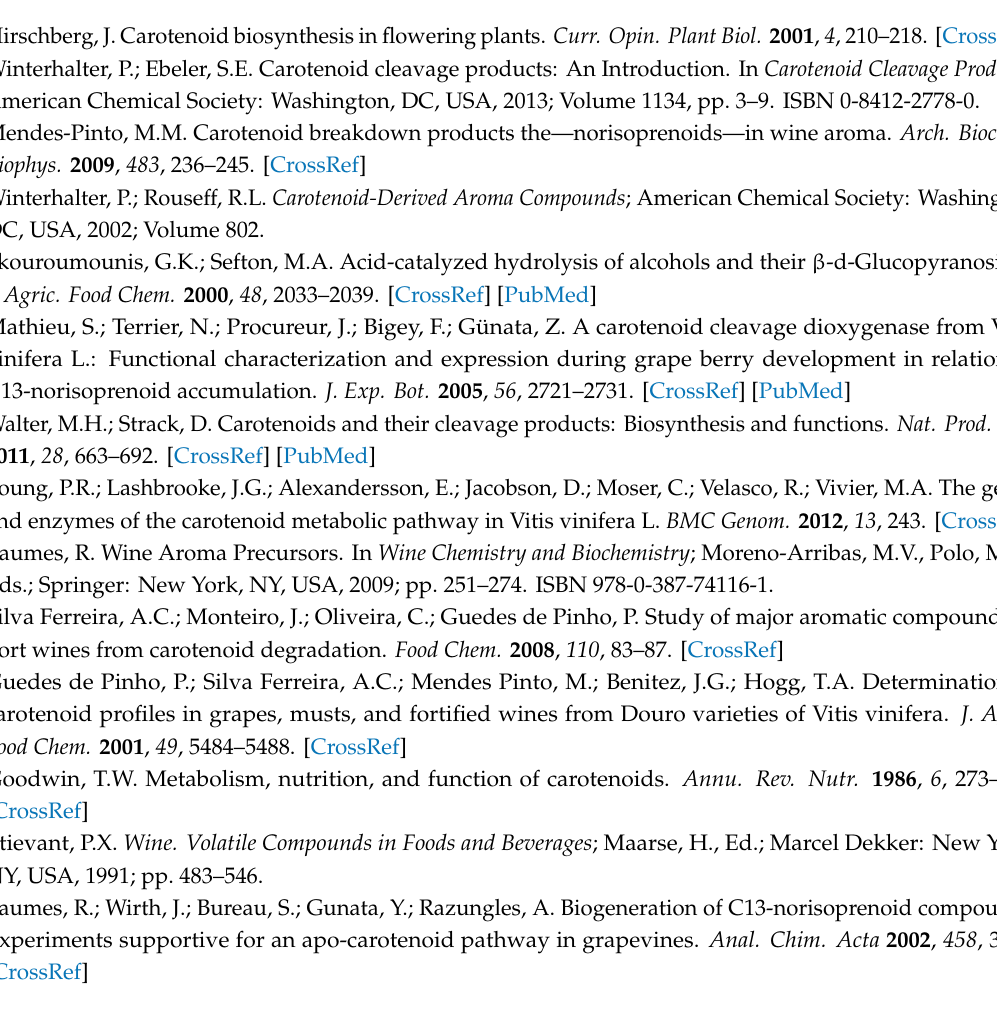
Table S1: Supplementary Table S1. Results of the 3-way ANOVA, carried out on the carotenoid content ( µ g berry-1) and concentration (mg kg-1) of the South facing vineyard considering the two levels of vigour (V + and V-), the two seasons and the four sampling dates as factors of